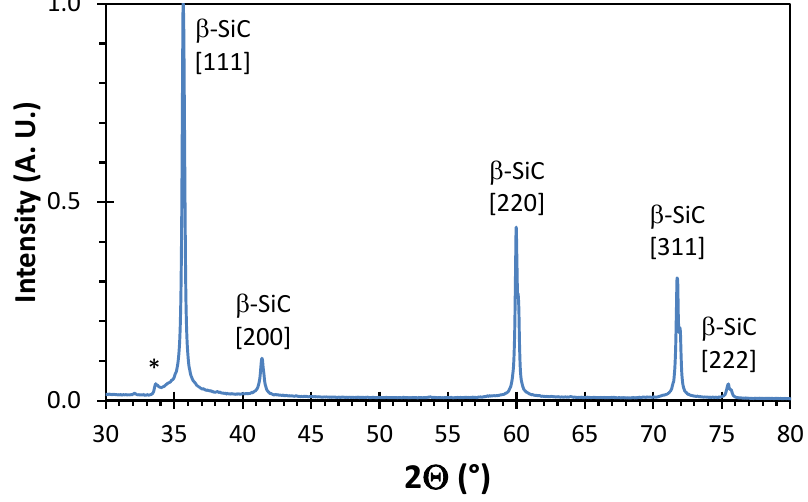
Figure 1. XRD pattern acquired on a cross-linked and pyrolyzed methylphenylvinylhydrogen polysiloxane preceramic polymer sample.